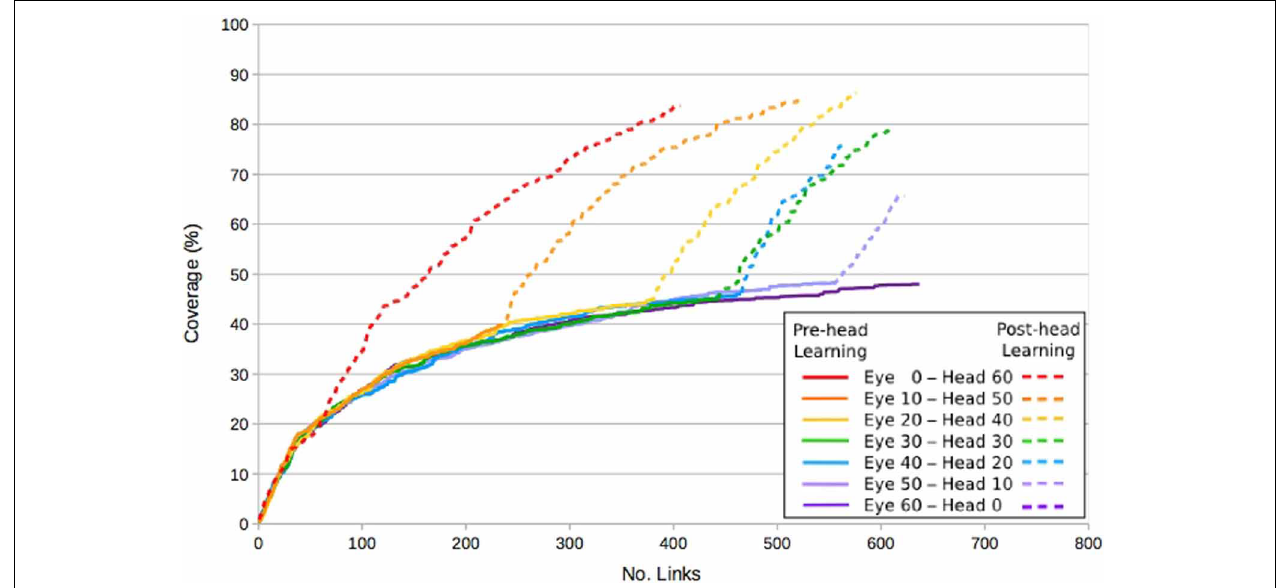
FIGURE 7 | Graph showing the effect of a Type B constraint on eye learning, when the head constraint is lifted at 10min